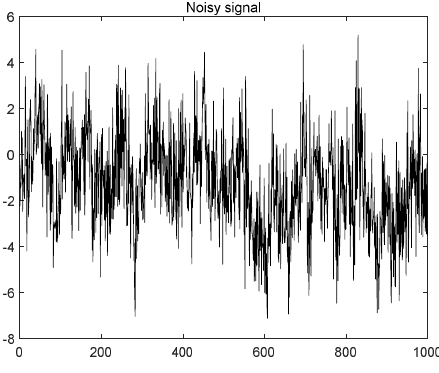
Figure 7. 1/ f noise signal.